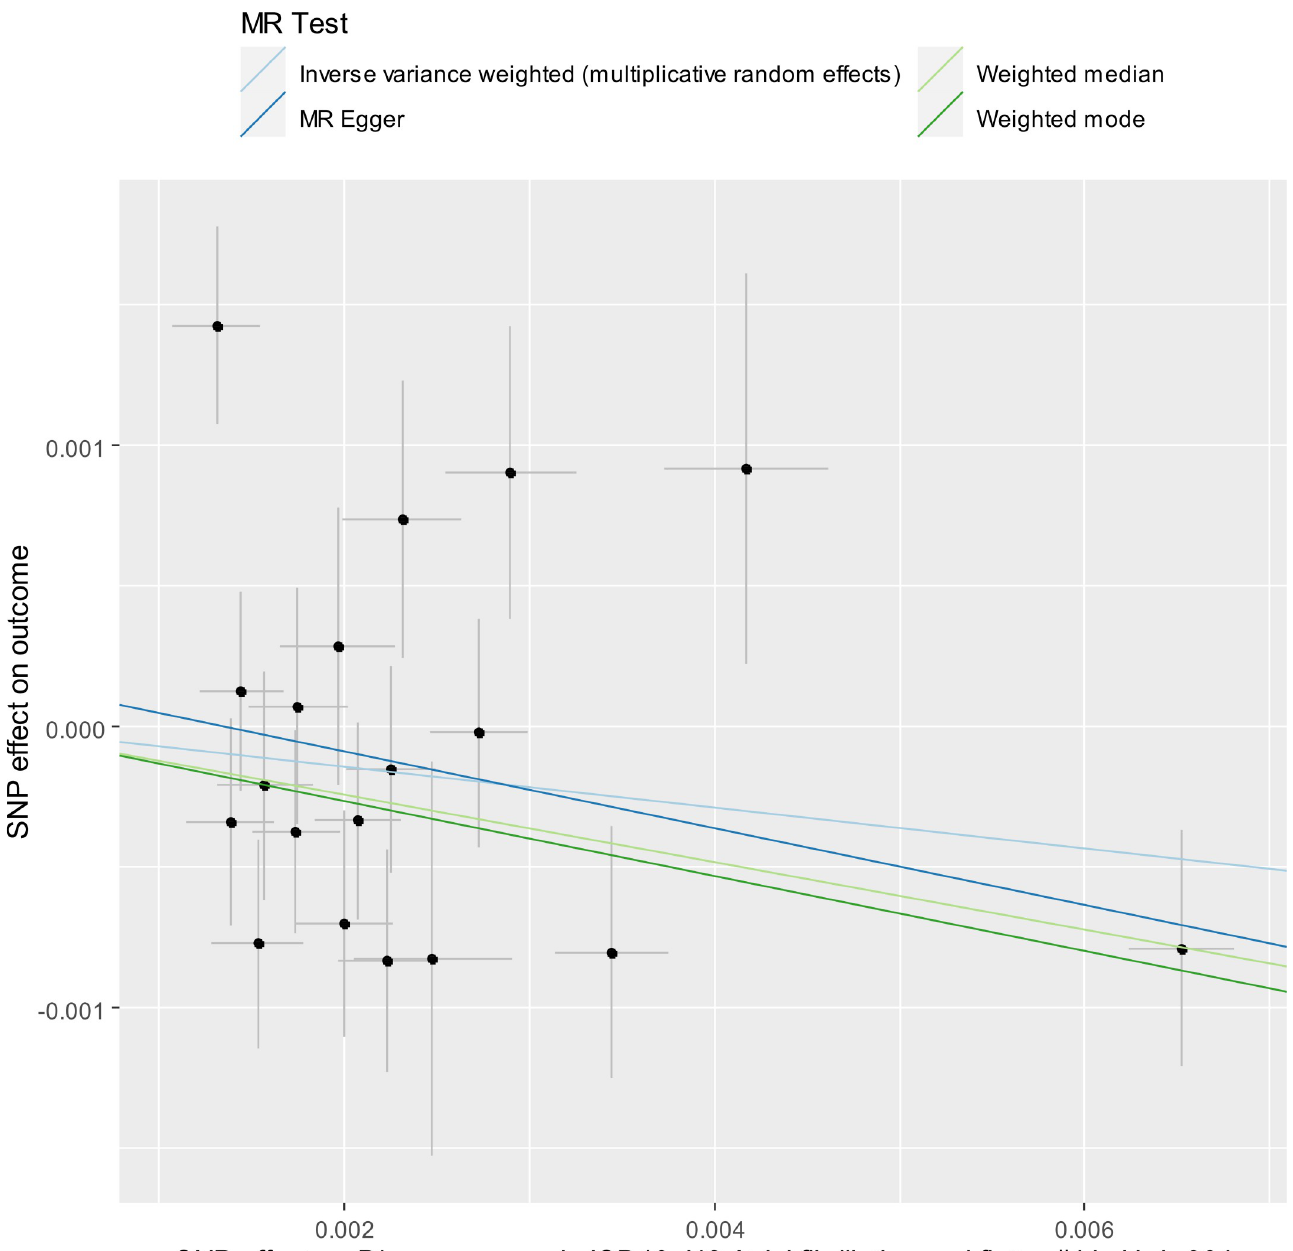
Fig 1. Scatter plot for estimating the risk of AF/F on the change in eGFR. Each black point representing a SNP is plotted in relation to the effect size of the SNP on the exposure (x-axis) and on the outcome (y-axis) with corresponding standard error bars. The slope of each line corresponds to the causal estimate using IVW (light blue), weighted median (light green), MR-Egger regression (blue), and weighted mode (green) method. decreased eGFR (beta for log [eGFR] per log OR of AF/F, -0.0721; SE, 0.0585) [19]; however, the effect was not significant ( P = 0.23). The results of both the weighted median and weighted mode methods revealed consistent results with suggestive significance. The MR-Egger inter- cept indicated little evidence of horizontal pleiotropy. MR-PRESSO global and outlier tests indicated that rs796427 was an outlier SNP ( P < 0.0038), as suggested by the funnel plot